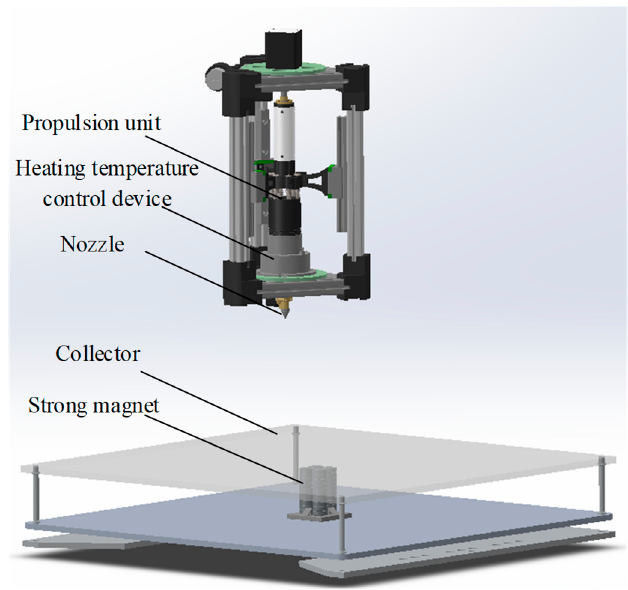
Figure 8. Schematic diagram of magnetic spinning solution.